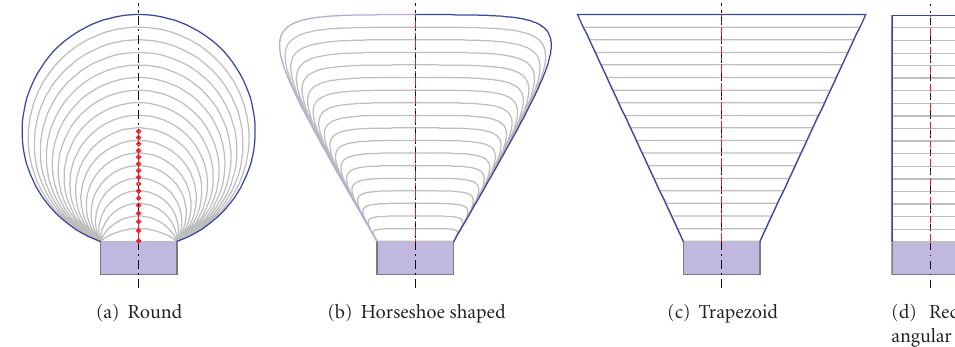
Figure 5: Four type of cross-section shapes.